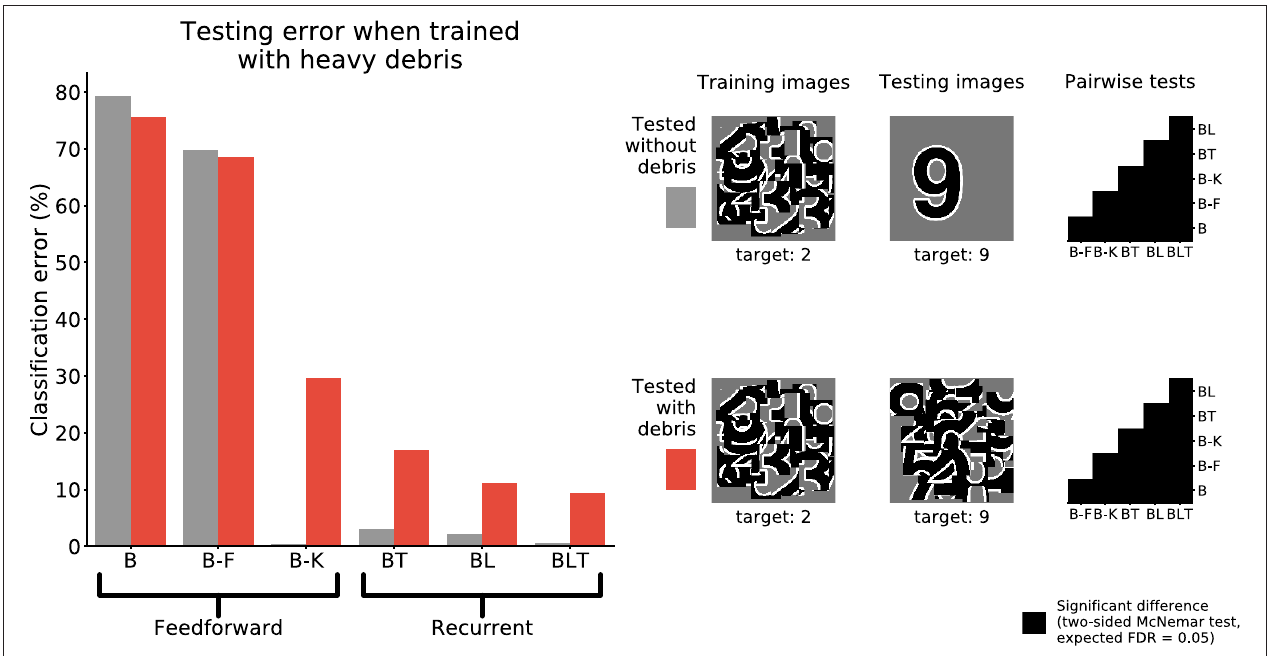
FIGURE 6 | Classification error for all models trained under heavy debris conditions and tested with or without debris. Examples of the images used to train and test the networks are also shown. Matrices to the right indicate significant results of pairwise McNemar tests. Comparisons are across models and within image sets. Black boxes indicate significant differences at p < 0.05 when controlling the expected false discovery rate at 0.05.